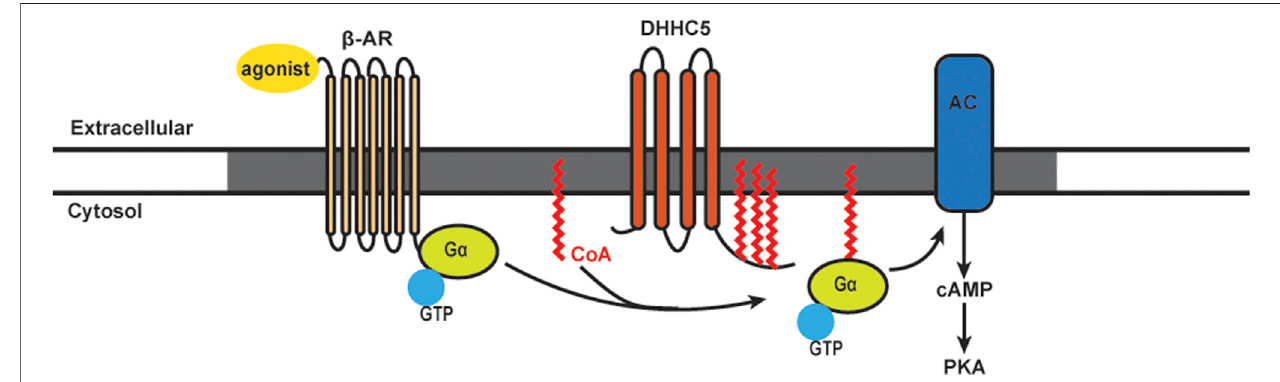
FIGURE 2 | Schematics of S-acylation of G α protein and β -AR signaling pathway. Upon agonist stimulation, β -adrenergic receptors ( β -AR) bind DHHC5 palmitoylatedG α andleadstotheactivationofadenylylcyclase(AC)andproductionofcAMP,followedbyactivationofProteinKinaseA(PKA). β -AR,ACandcertainPKA subunits are enriched in caveolae (grey).